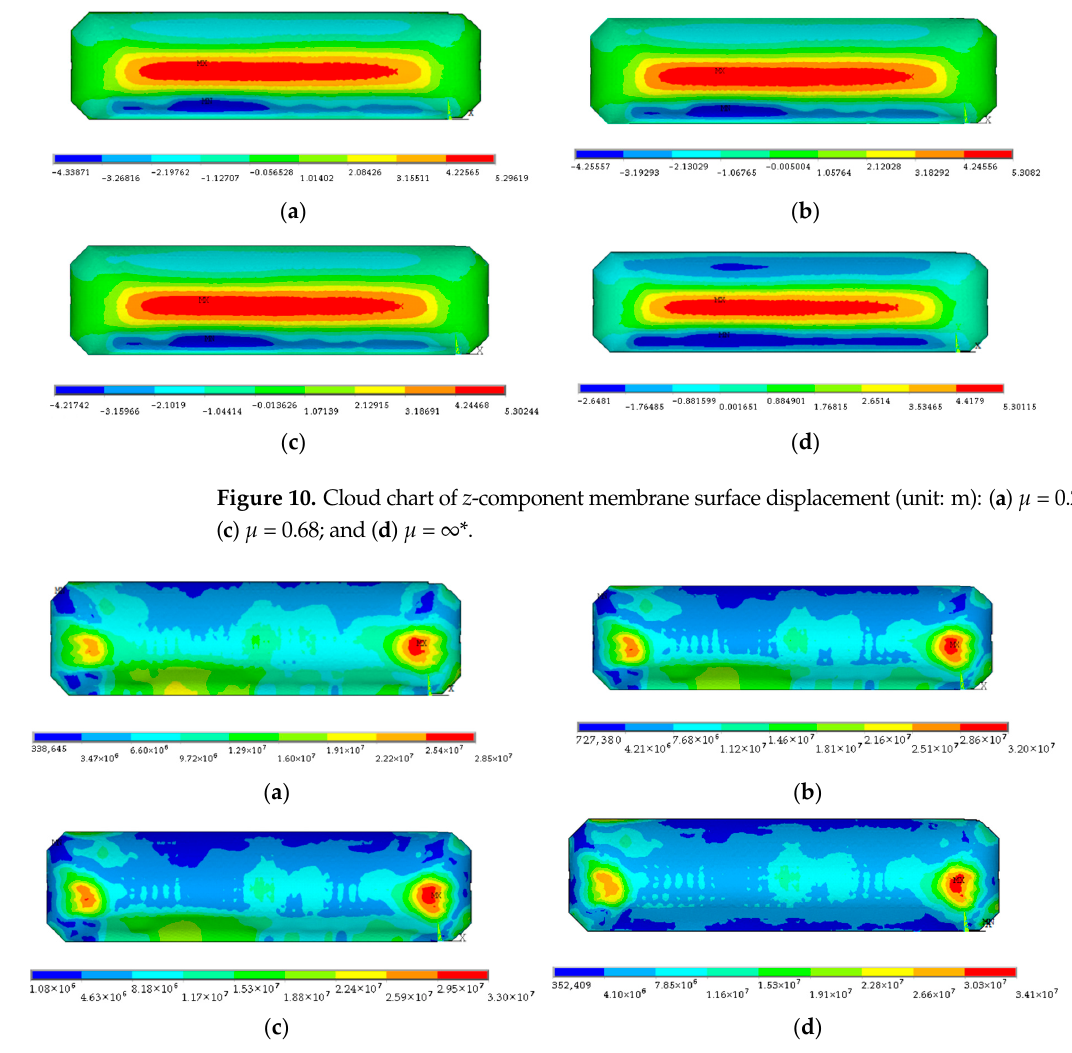
Figure 11. Stress cloud chart of membrane surface under equivalent static wind load action (unit: Pa): ( a ) μ = 0.2; ( b ) μ = 0.44; ( c ) μ = 0.68; and ( d ) μ = ∞ *. Figure 11 depicts the membrane surface stress cloud chart for the air-supported membrane structure. From the results, the membrane surface stress distribution when considering the cable-membrane contact is different from that calculated for the binding model, and as the friction coefficient increases, the membrane surface stress increases sig- nificantly, particularly at the membrane poles, and the membrane surface stress distribu- tion gradually converges on the binding model stress distribution. When the friction co- efficient is between 0.2 and 0.68, the maximum displacement of the membrane surface falls by 2.8%, and the maximum stress of the membrane surface increases by 15.8%. As seen in Figures 10 and 11, when employing the binding model, the displacement and von Mises stress on the windward region of the membrane are overestimated by 26.9% and 19.6%, respectively. 4.2.2. Cable Net Figure 12 illustrates the axial force cloud diagram for the cable net of the air-sup- ported membrane construction. The numerical findings indicate that the cable axial force increases with an increasing friction coefficient when the cable-membrane contact is con- sidered; however, the computed results of the contact model are always less than those of the binding model. The stress distribution cloud chart reveals that the increase in the fric- tion coefficient has no significant effect on the stress distribution of the cable axial force when the cable and membrane are in contact, and when the stress concentration occurs in the axial force of the cable net of the binding model. Combining these two aspects, when using the binding model, in the process of deforming and displacing the membrane, due to the cable-membrane common nodes and the difficulty of free movement of the cable net, the degree of mutual compression between the cable and the membrane is severe, thereby easily generating stress concentration, and the axial force increases. However, when using the cable membrane contact model, because the cable net can slip under the influence of the wind, the degree of mutual compression between the cable and the mem- brane is less, so the cable net stress is more uniform, and the structural forces are closer to their actual values. When the binding model is employed, the axial force of the re- strained cable element s is overestimated by approximately 26%.